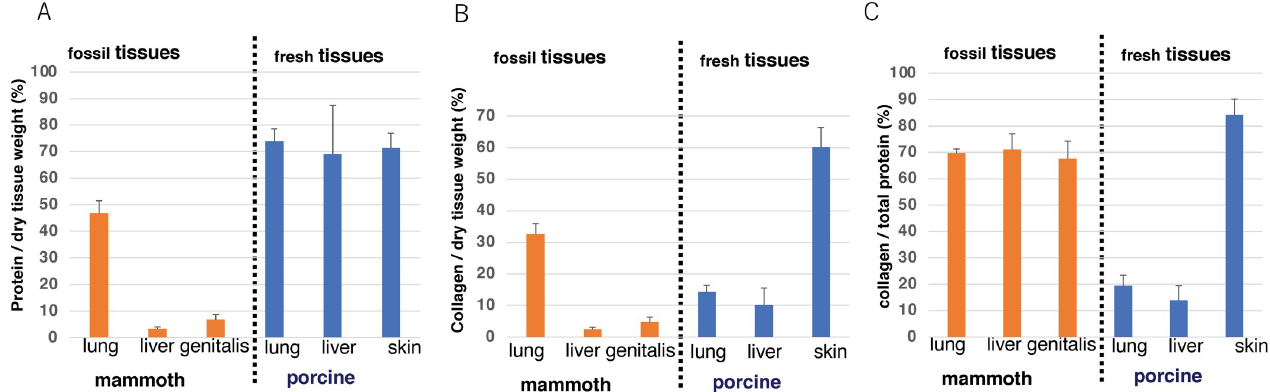
Fig 6. Comparison of protein and collagen content in mammoth tissue and fresh tissue. (a) Percentage of protein content against the dry weight of tissue estimated using amino acid analysis data. (b) Percentage of collagen content against the dry weight of tissue estimated using amino acid analysis data. (c) Ratio of collagen to total protein in the tissue. All the data is average of three or four independent analyses and standard deviations were indicated.